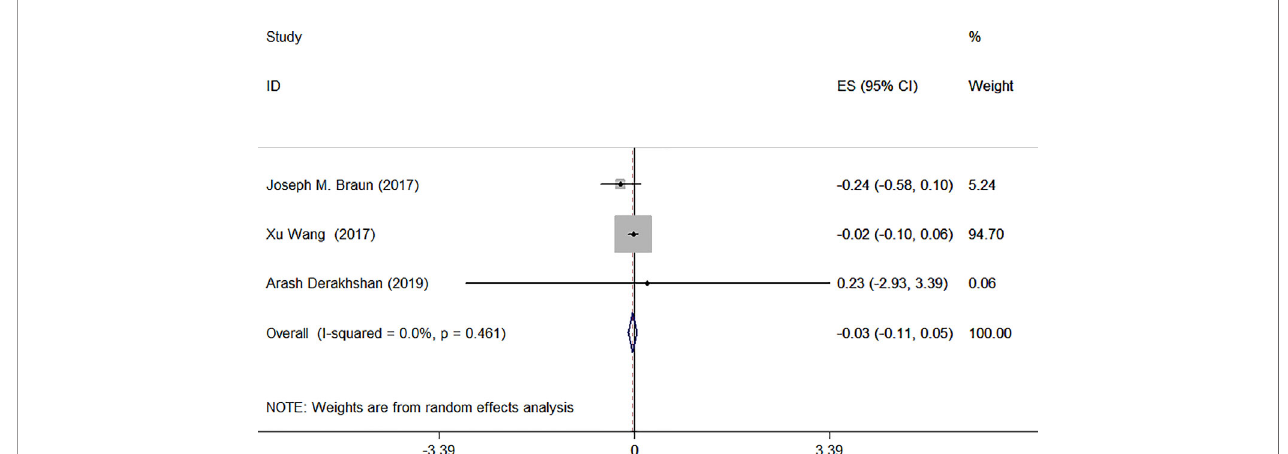
FIGURE 6 | Forest plot of prenatal exposure to TCS and maternal TSH levels standardized using urinary